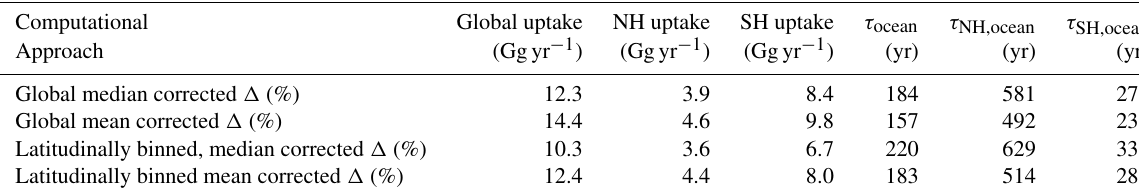
Table 4. Oceanic uptake rates and partial atmospheric lifetimes with respect to ocean uptake from a 90ppt atmosphere using the Wanninkhof (2014) air–sea exchange parameterization applied to the global median corrected saturation anomaly, global mean corrected saturation anomaly, median corrected saturation anomalies for 10 ◦ latitudinal bins, and mean corrected saturation anomalies for 10 ◦ latitudinal bins. The latitudinal bins are defined in Table 3. The variability in these results demonstrates the uncertainty associated with computational approach. The partial lifetimes are independent of atmospheric amount.